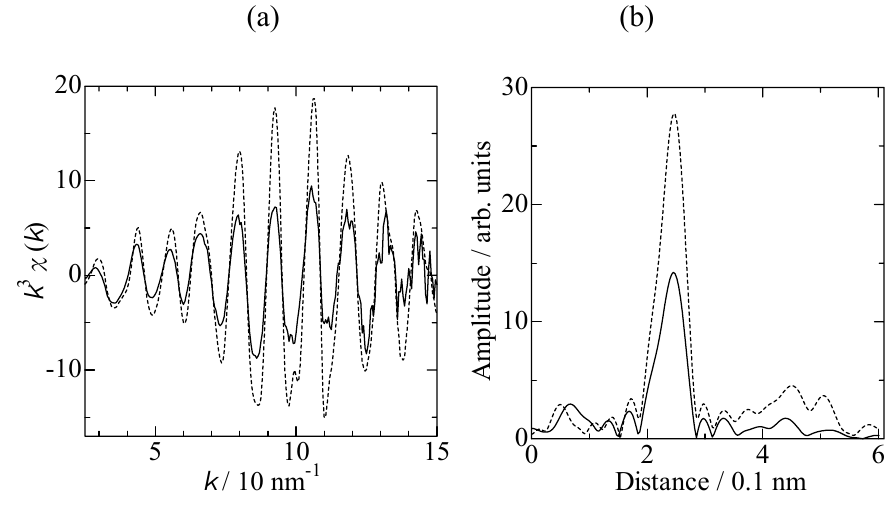
Figure 3. Pd-K edge EXAFS (a) k 3 χ ( k ) and (b) their Fourier transforms of Pd/USY in DMAc (continuous line) and Pd foil (dotted reduced with bubbling 6%-H 2